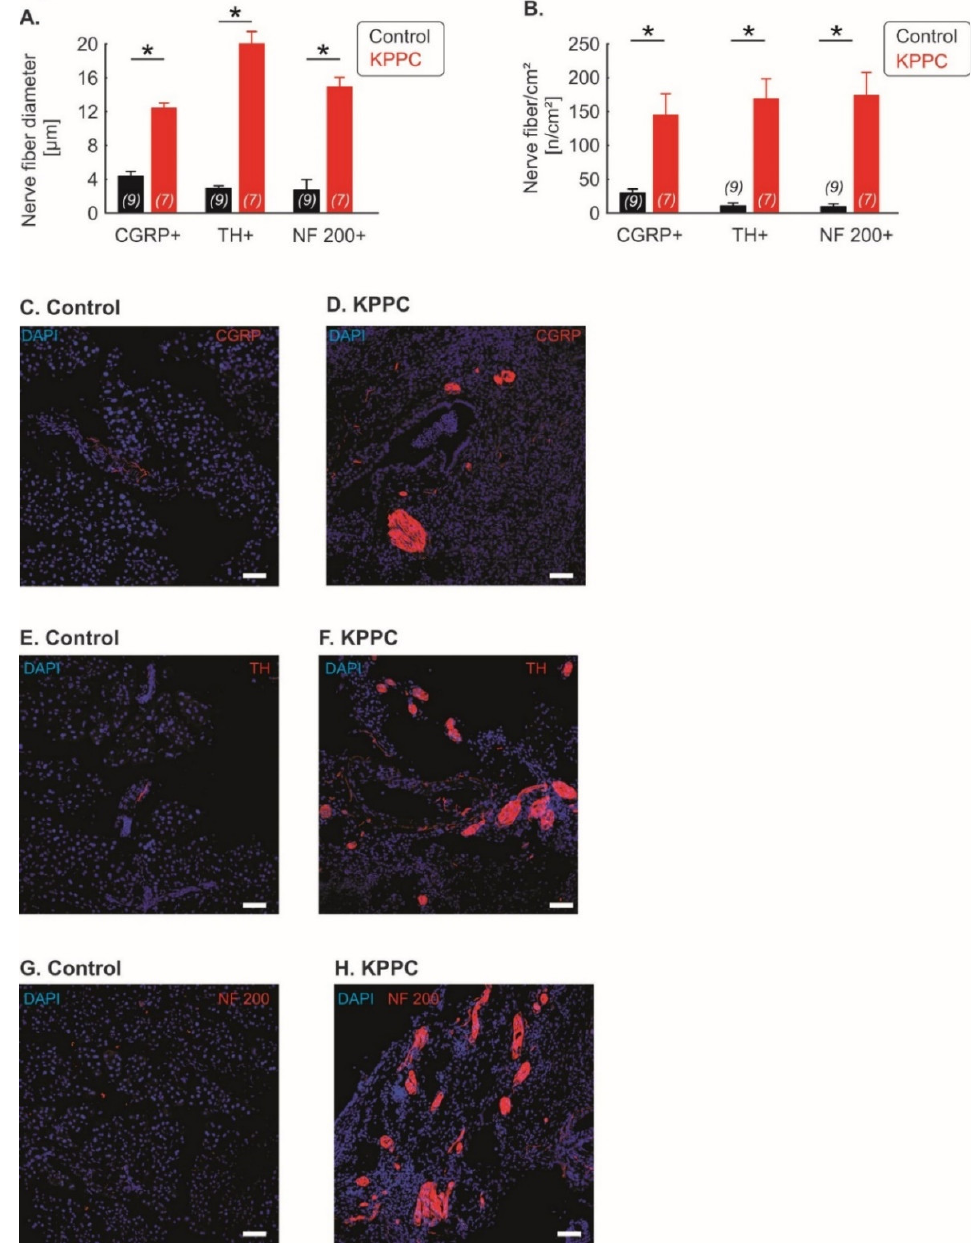
Figure 3. Neuronal remodeling is detectable across several fiber classes . ( A – H ): Quantification of the nerve fiber hypertrophy ( A ) and nerve fiber density ( B ) for Calcitonin Gene-Related Peptide (CGRP)-positive fibers (peptidergic nociceptive fibers), Tyrosine hydroxylase (TH)-positive fibers (sympathetic fibers and C-low threshold mechanoreceptors) and Neurofilament Protein 200 (NF200)-positive fibers (A beta fibers). The number of investigated mice is given in brackets. Rep- resentative images are shown in ( C – H ) (scale bar = 100 µm). Data are presented as mean ± S.E.M. * p < 0.05 in comparison between KPPC and control mice, Student’s t -test.